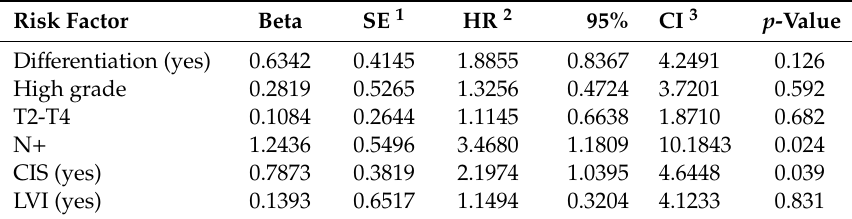
Table A1. Cox regression model for disease-free survival. The model includes the clinicopathological variables selected using univariate survival analysis (with p < 0.10).